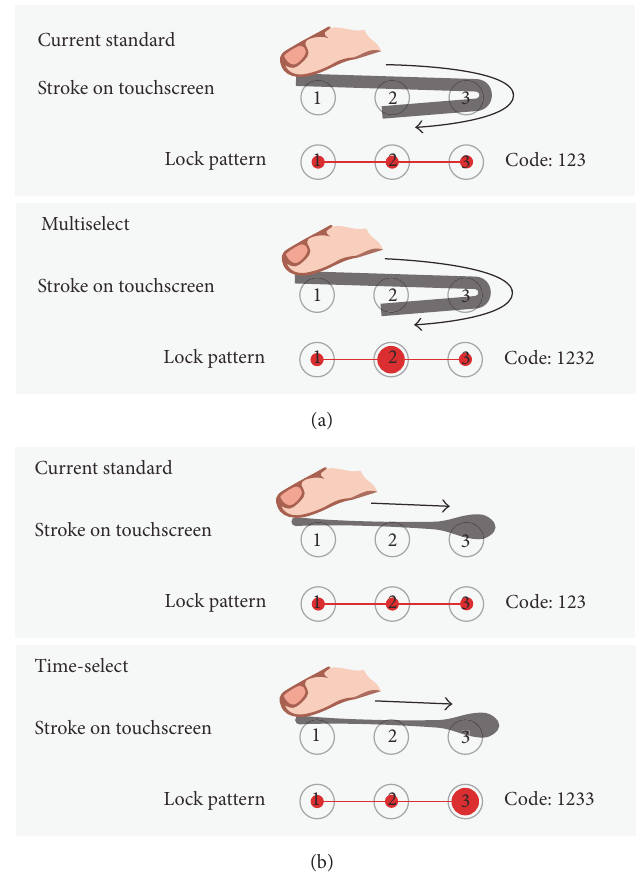
Figure 1: Pair-wise comparison of the proposed lock mechanisms to the standard pattern lock. In each illustration, the unlock action starts at node “1” and ends at the large red dot. (a) In the multiselect condition, the “2” is added to the pattern by moving over a previously selected node. (b) In the time-select condition, a second “3” is added to the pattern. “Long-press” allows the current node to be reselected and added to the